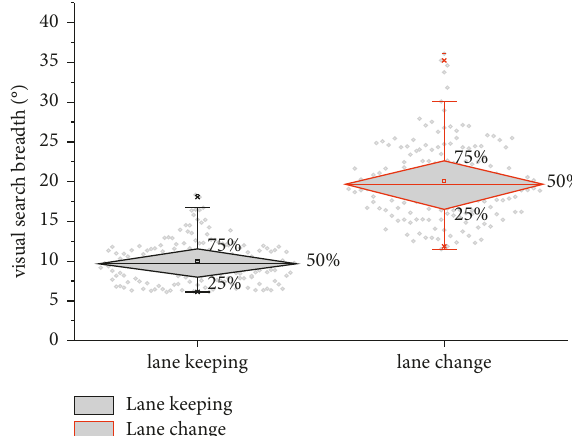
Figure 3: Statistical results on the breadth of the driver’s visual search during the change of lanes.